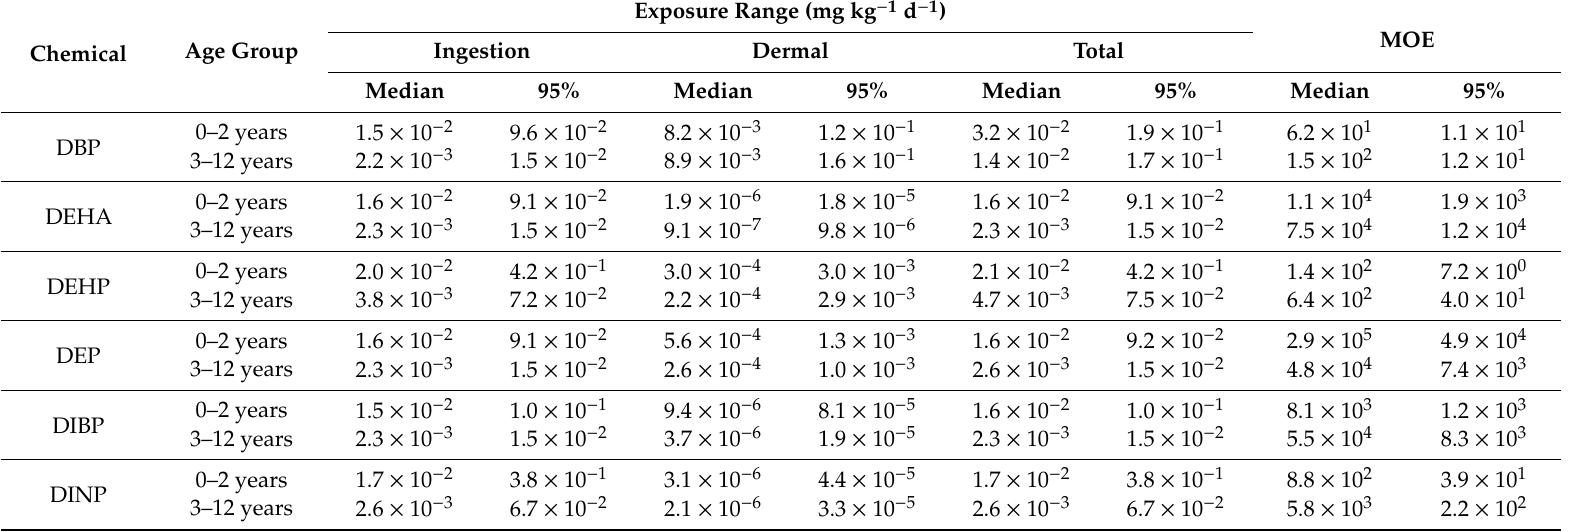
Table 4. Estimated exposure ranges via ingestion and dermal contact of chemicals in children’s products and their corresponding margin of exposure (MOE) from reference